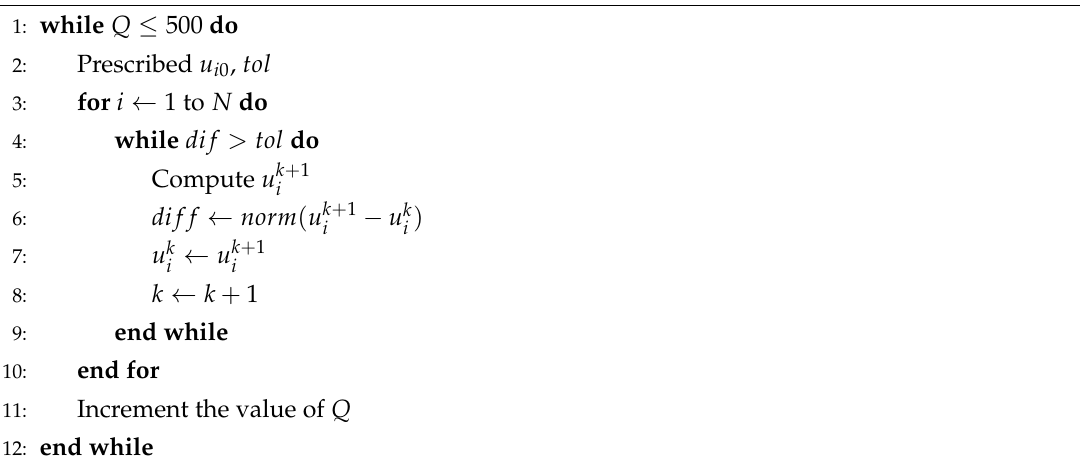
Algorithm 1 Marching in time up to stationary solution